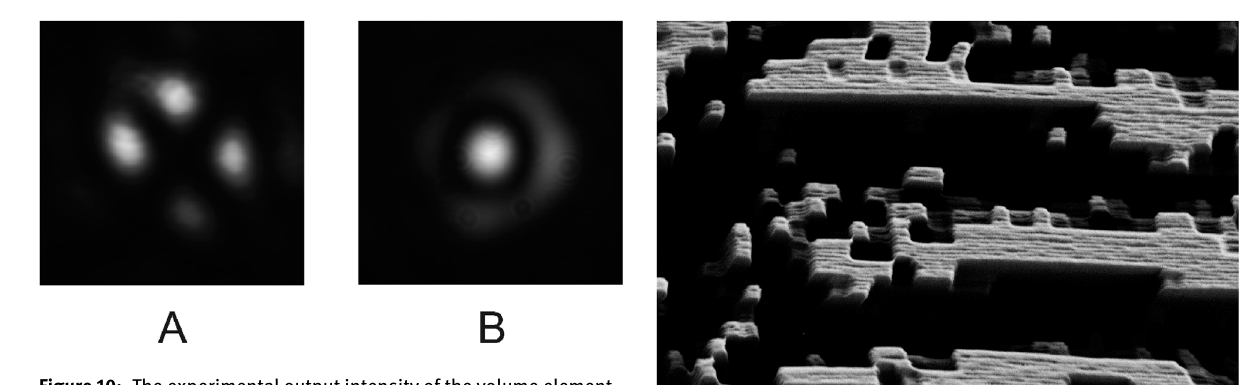
Figure 10: The experimental output intensity of the volume element for (A) + 3 ° incidence angle to yield LP 21 and (B) − 3 ° incidence angle to yield LP 02